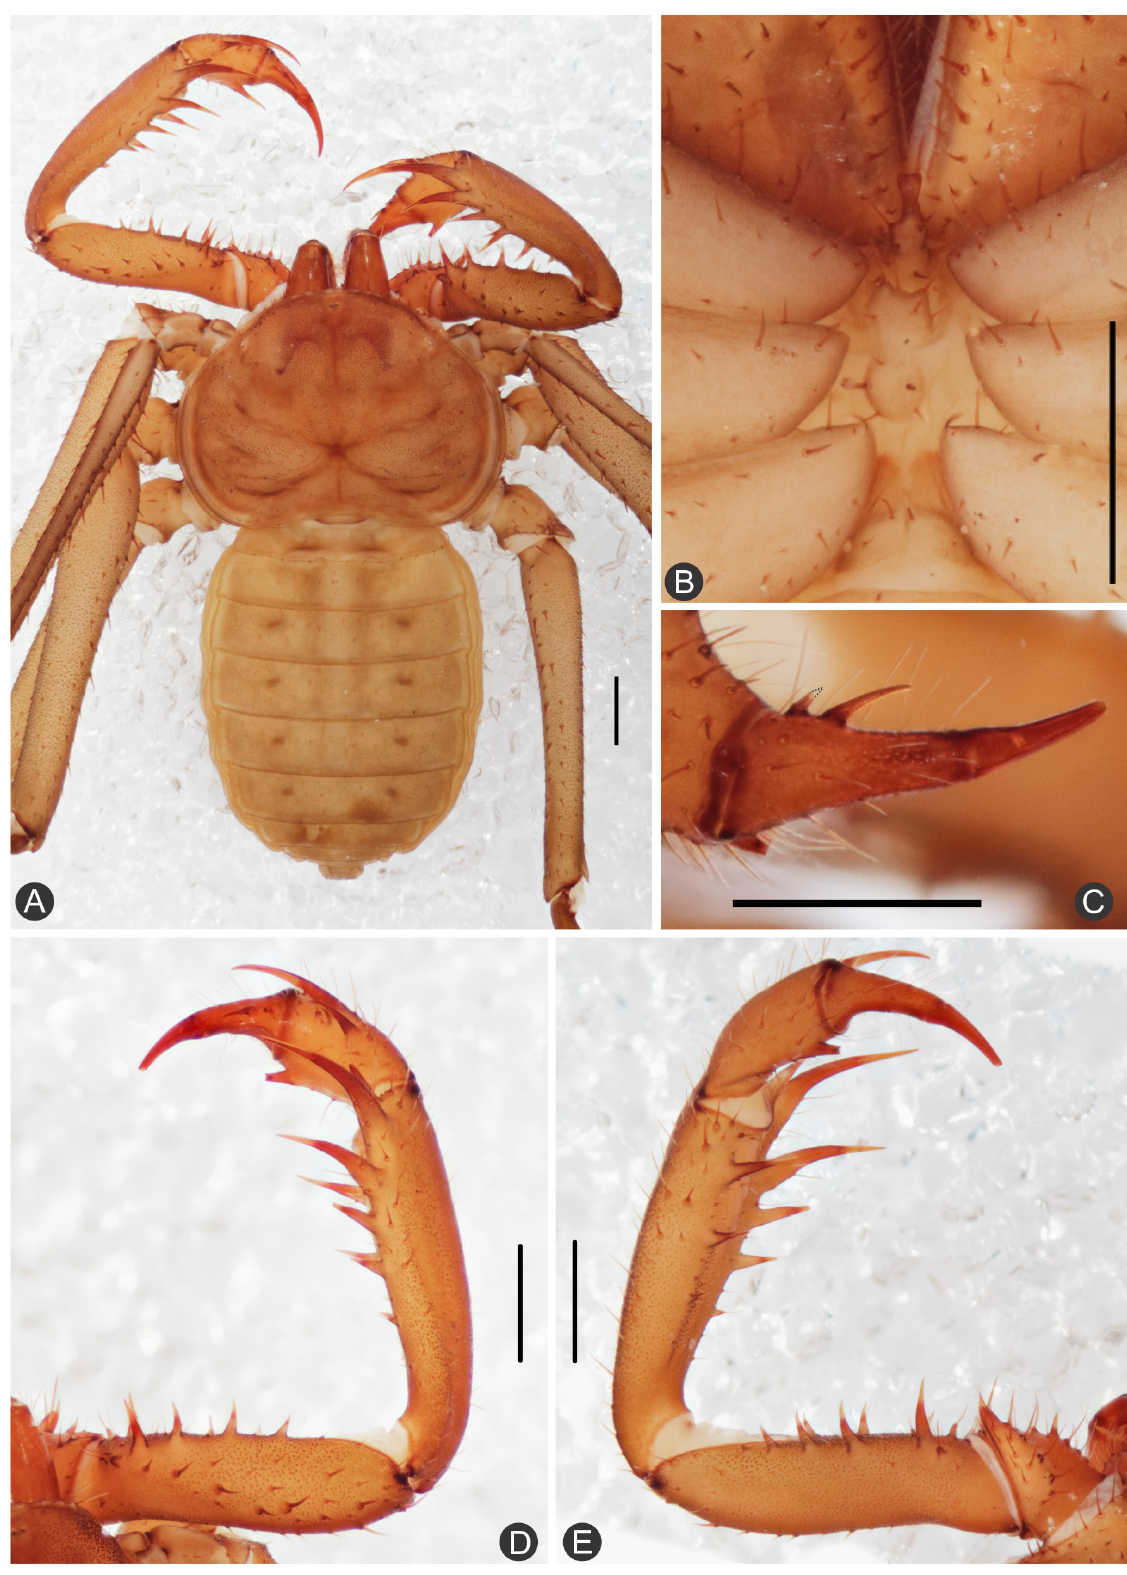
Fig. 1. Charinus israelensis sp. nov. A . Habitus, dorsal view. B . Sternum. C . Frontal view of pedipalp distitarsus. D . Pedipalp, dorsal view. E . Pedipalp, ventral view. Scale bars: